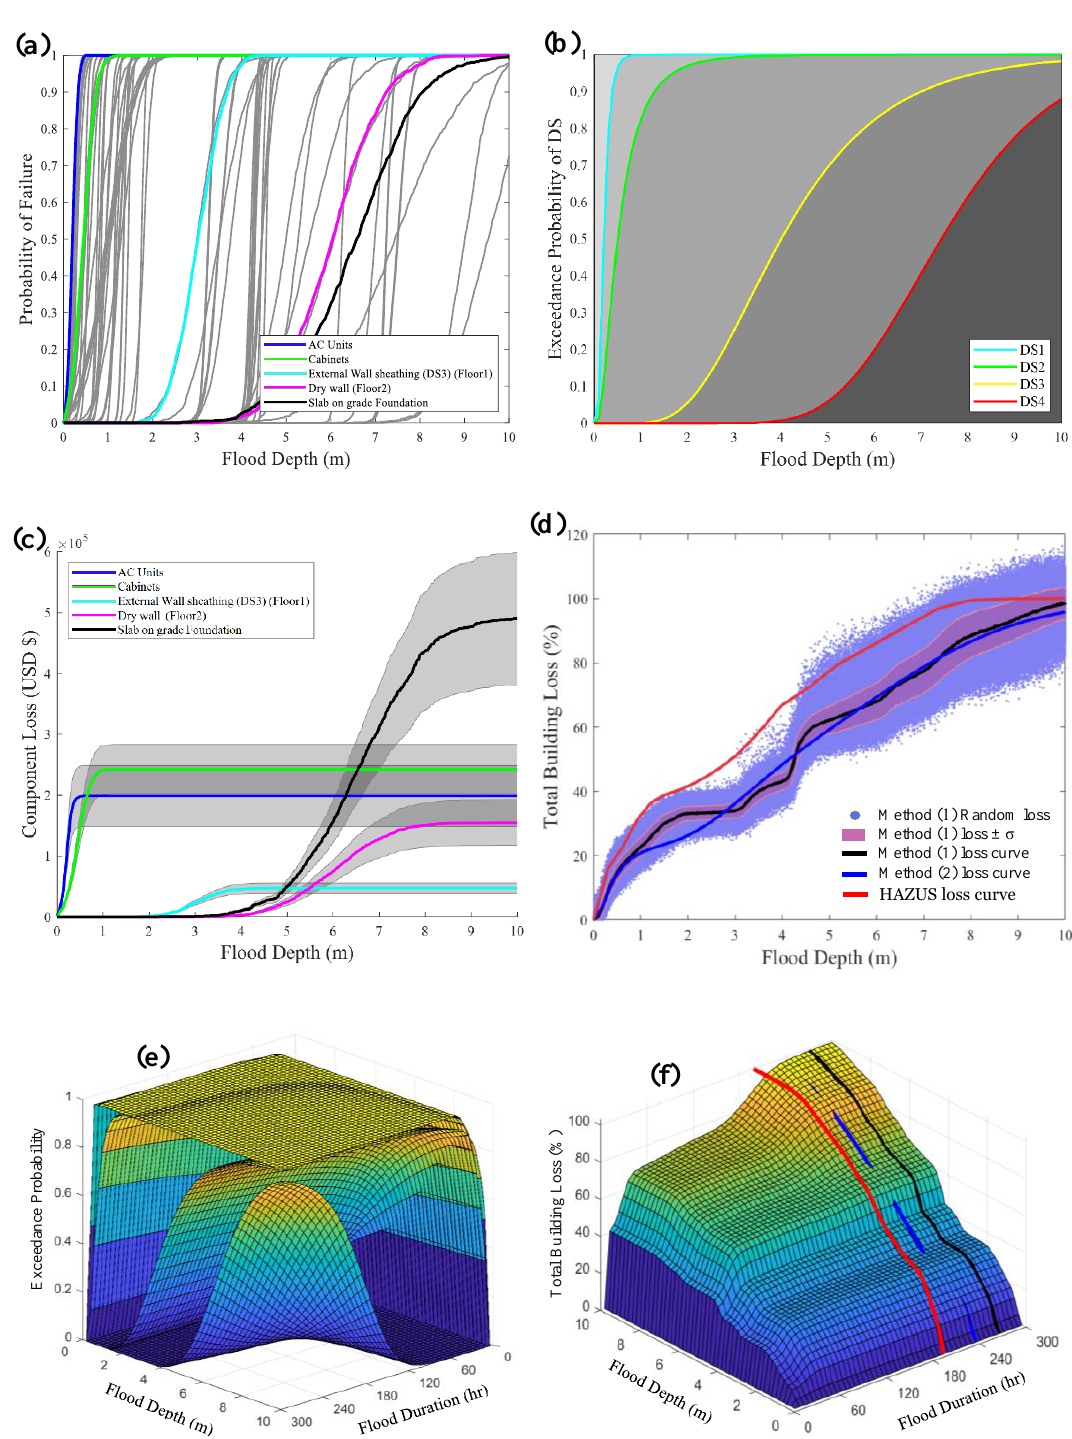
Figure A25. F11 archetype analysis results: ( a ) Component fragility curves; ( b ) Building fragility curves; ( c ) Selected components’ loss curves; ( d ) Building loss curves; ( e ) Building fragility surfaces; ( f ) Building loss surface.